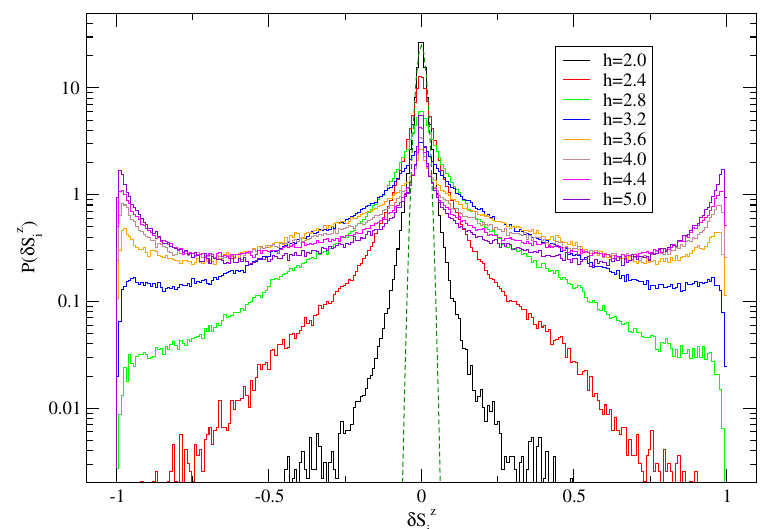
Figure 8: Probability distribution of the difference in local magnetization δ S z = 〈 n | S z | n 〉 − 〈 n (cid:48) | S z | n (cid:48) 〉 (averaged over all positions i ) of two nearby eigenstates i i i at the same energy density, for different disorder strengths and chain size L = 24. The dotted line is a gaussian fit to the distribution at the lowest disorder h = 2.